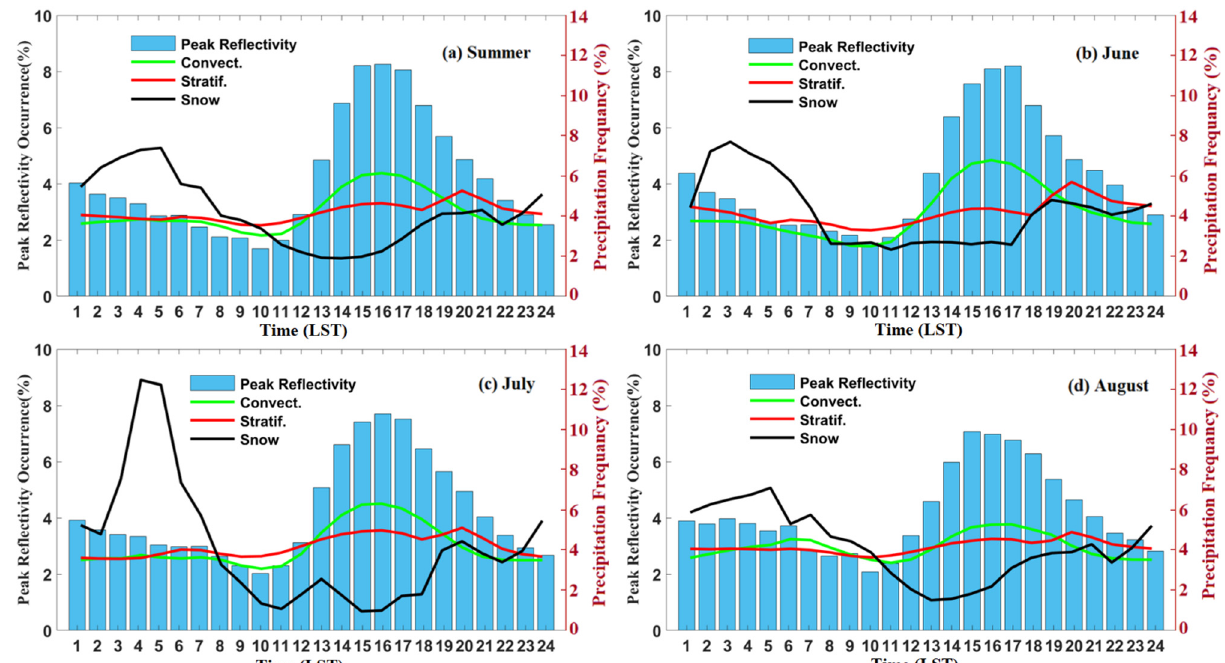
Figure 7. ( a ) Diurnal cycle of peak reflectivity (bars) and diurnal cycle of occurrence ratio of each precipitation types (curve) in summer. ( b – d ) Diurnal cycle of peak reflectivity (bars) and diurnal cycle of occurrence ratio of each precipitation types (curve) in from June to August of 2018 to 2021.